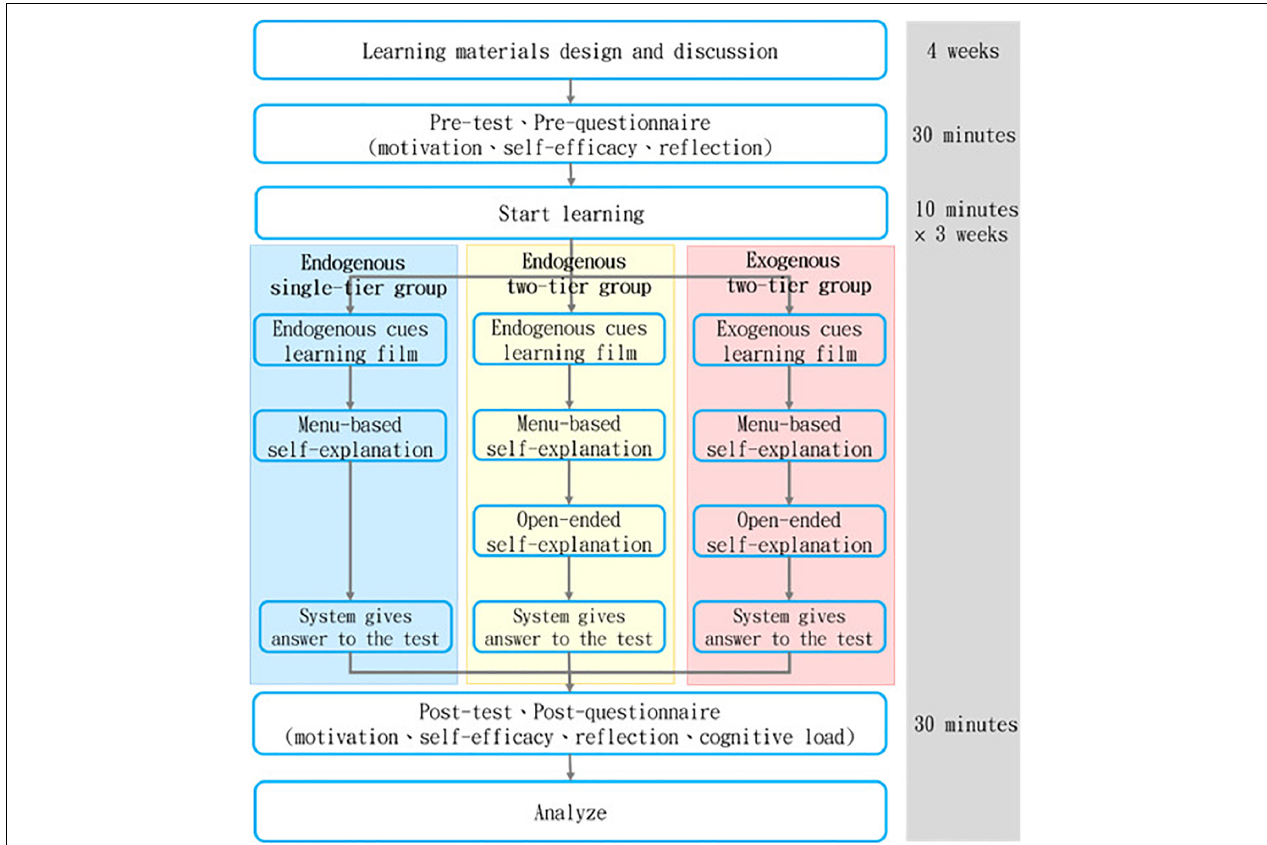
FIGURE 5 | Learning